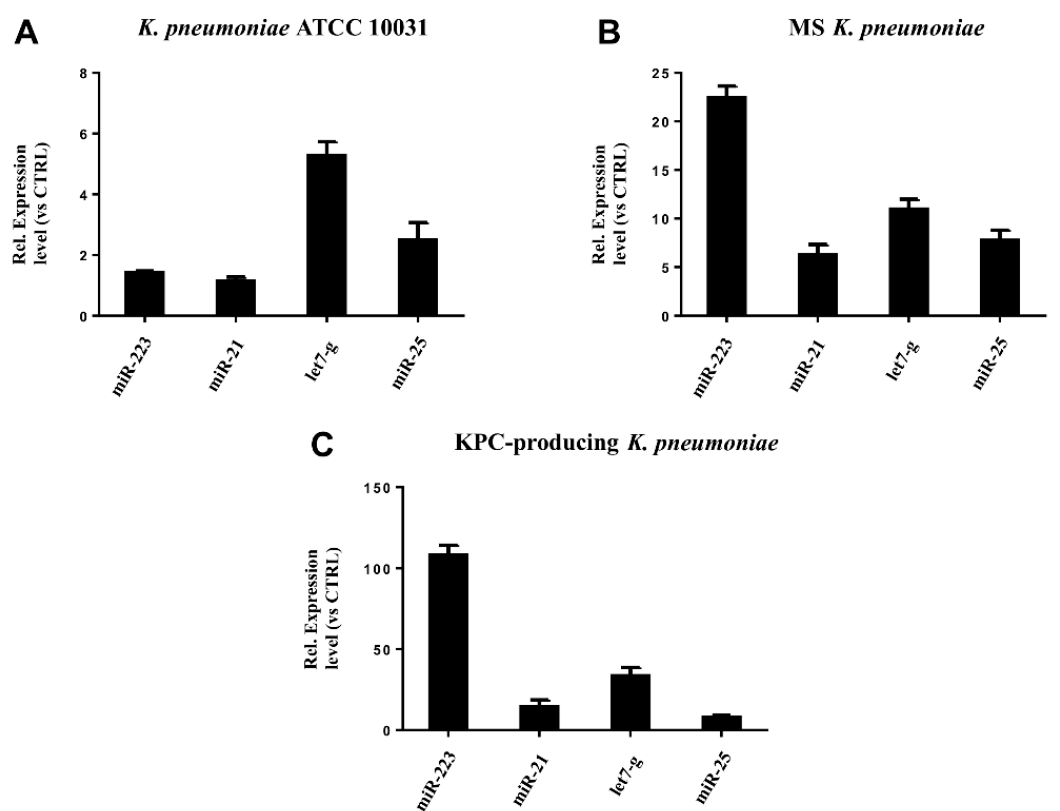
Figure 6. Validation of miRNA microarray data by real-time PCR. The expression levels of miR-21, miR-25, miR223, and let-7g were consistent with the miRNA microarray results after treatment with K. pneumoniae ATCC 10031 ( A ), MS K. pneumoniae ( B ) and KPC-producing K. pneumoniae ( C ).